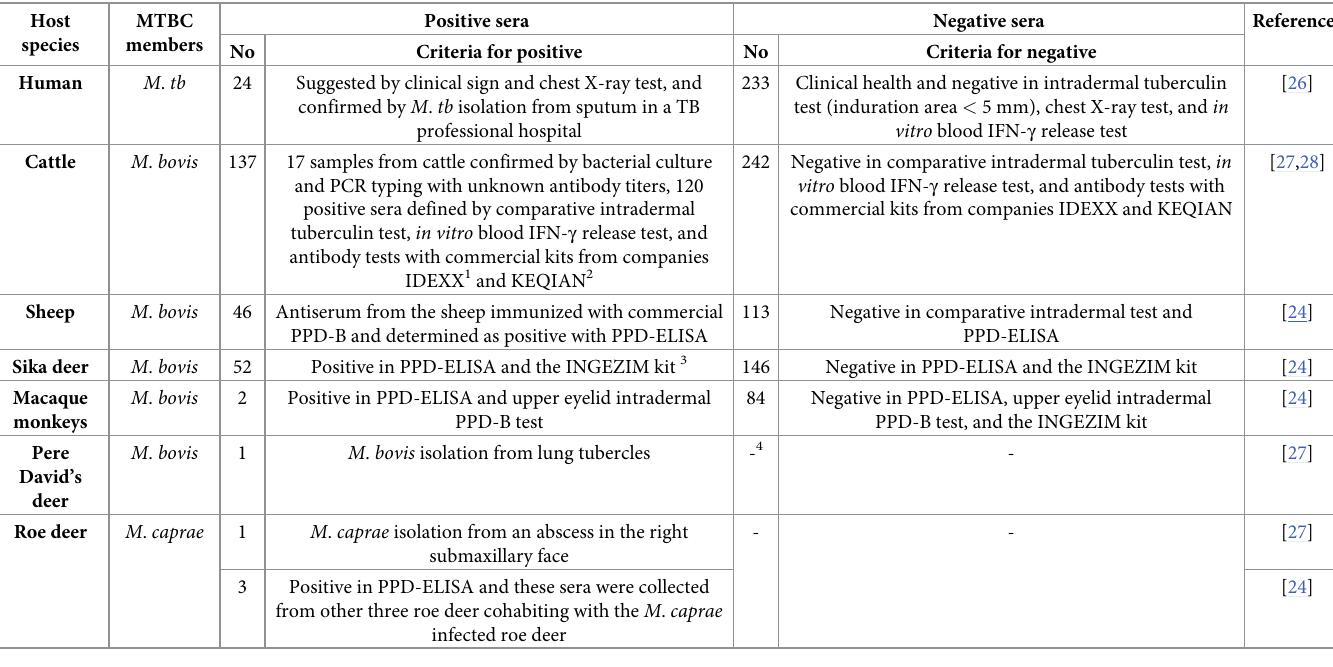
Table 1. Information on positive and negative serum samples collected previously and used in this study. Host